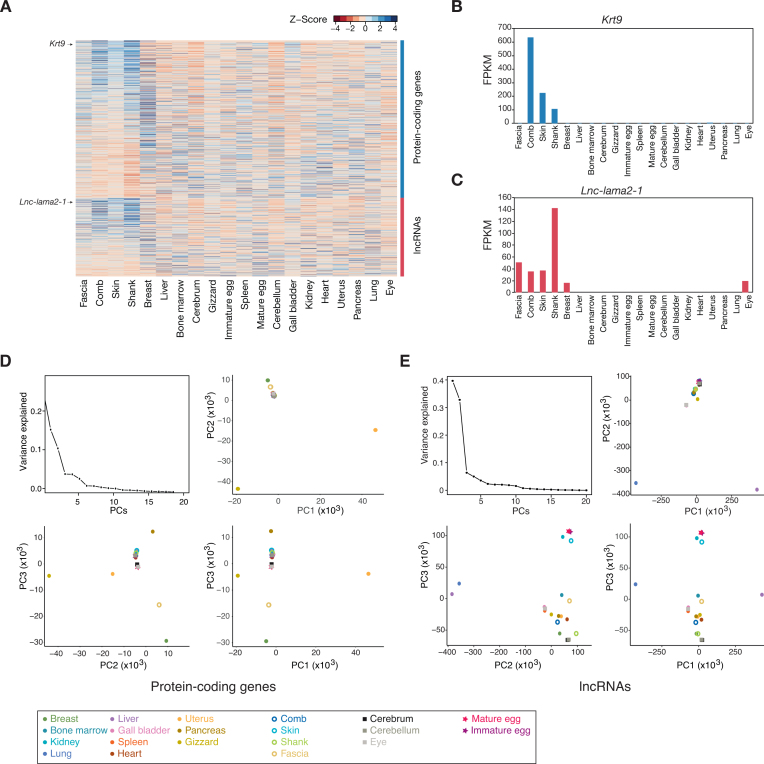

(A) The expression patterns of the genes expressed with \documentclass[12pt]{minimal}
\usepackage{amsmath}
\usepackage{wasysym}
\usepackage{amsfonts}
\usepackage{amssymb}
\usepackage{amsbsy}
\usepackage{upgreek}
\usepackage{mathrsfs}
\setlength{\oddsidemargin}{-69pt}
\begin{document}
}{}$ \ge 10\;$\end{document} FPKM in black tissues. Expression levels are indicated with a color-coded Z-score (red for low and blue for high expression) as shown in the key. (B) Expression levels of krt9 across 20 tissues. (C) Expression levels of lnc-lama2–1 across 20 tissues. (D) Principal component analysis (PCA) using tissue-specific protein-coding genes. PCs explaining the variances are indicated with the amount of the contribution in the top-left plot. PCA plots are shown with PC1, PC2, and PC3 plotted in a pairwise manner. Each tissue is indicated on the PCA plot with a specific color. (E) PCA using tissue-specific lncRNAs. Otherwise, as in (A).